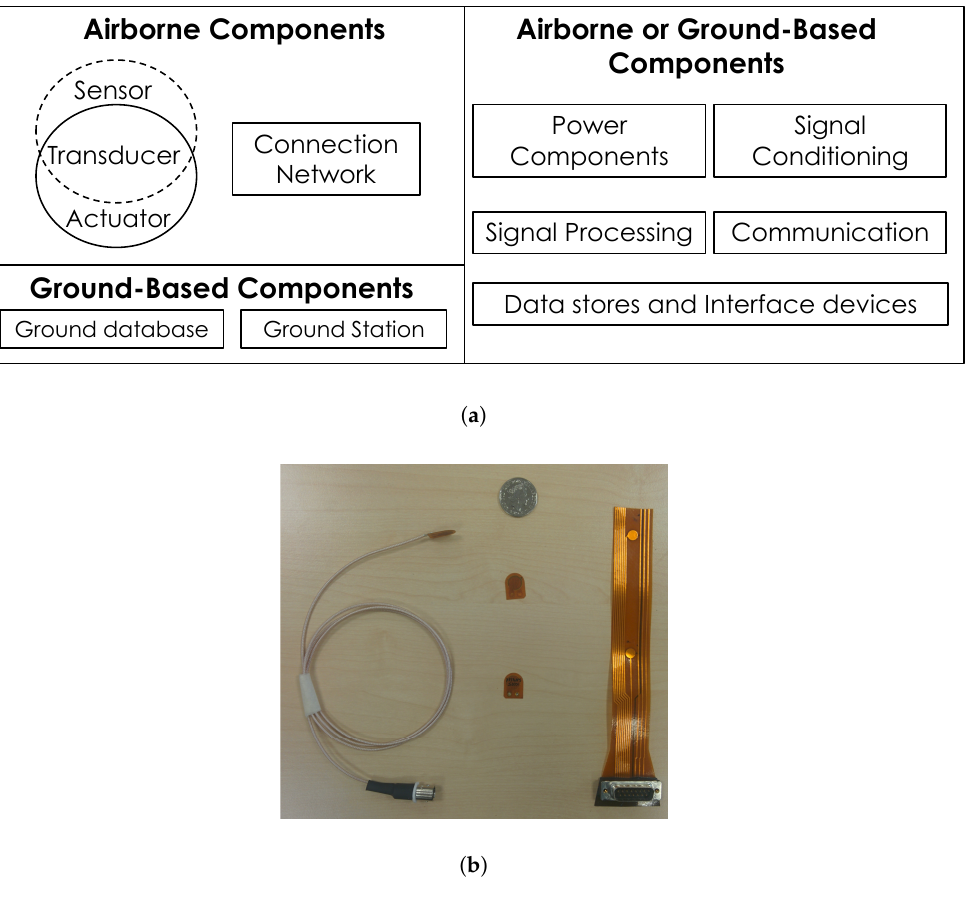
Figure 1. ( a ) SHM components (adapted from [25]); ( b ) piezoelectric